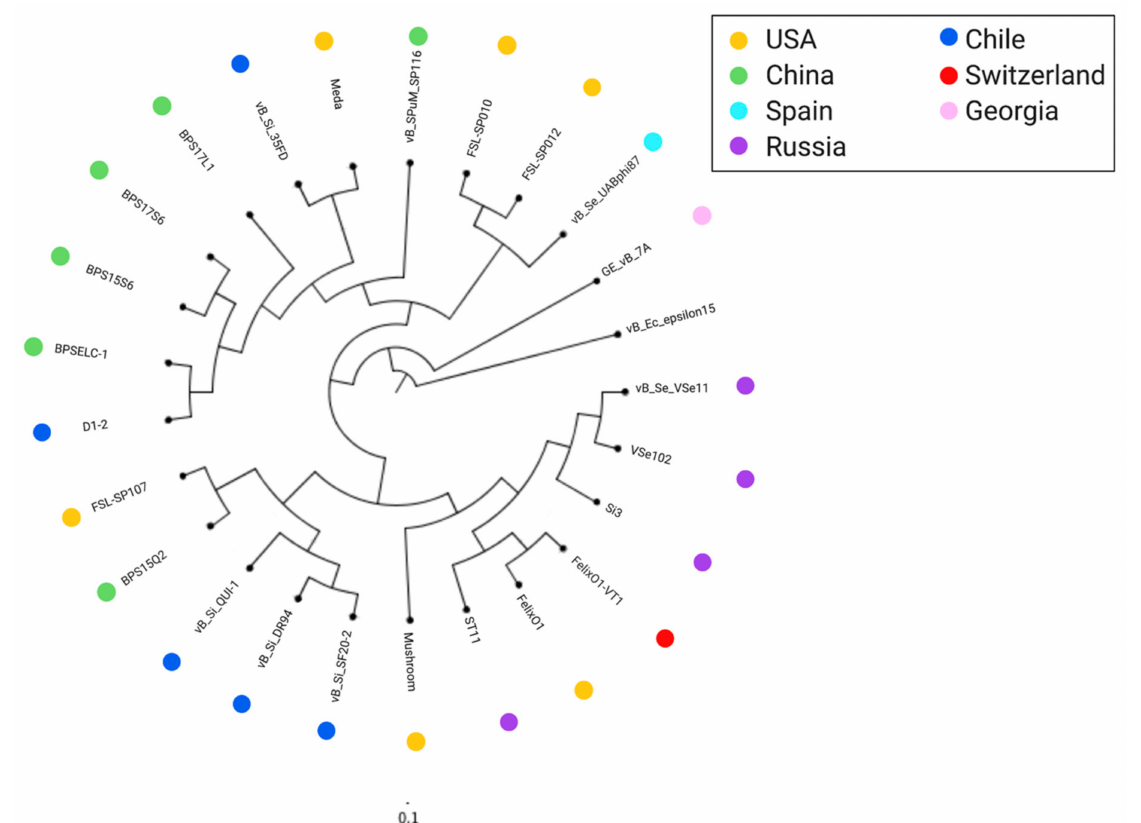
Figure 3. Phylogenetic tree of phage vB_Si_35FD, vB_Si_DR94 and the 23 genomes downloaded from NCBI (rooted with vB_Ec_epsilon15). Three clades were observed: Clade A (light grey) with 7 phages, mostly from Russia (purple circles). Clade B (medium grey) contains 5 phages, mostly isolated from Chile (blue circles). Clade C (dark grey) has 11 phages, with a subclade of phages isolated from China (green circles). The singleton phage vB_St_GE7A was isolated from Georgia (pink circle). Phage vB_Ec_epsilon15 is the outgroup, it was not compared with the other Felixounavirus genomes compared in Figure